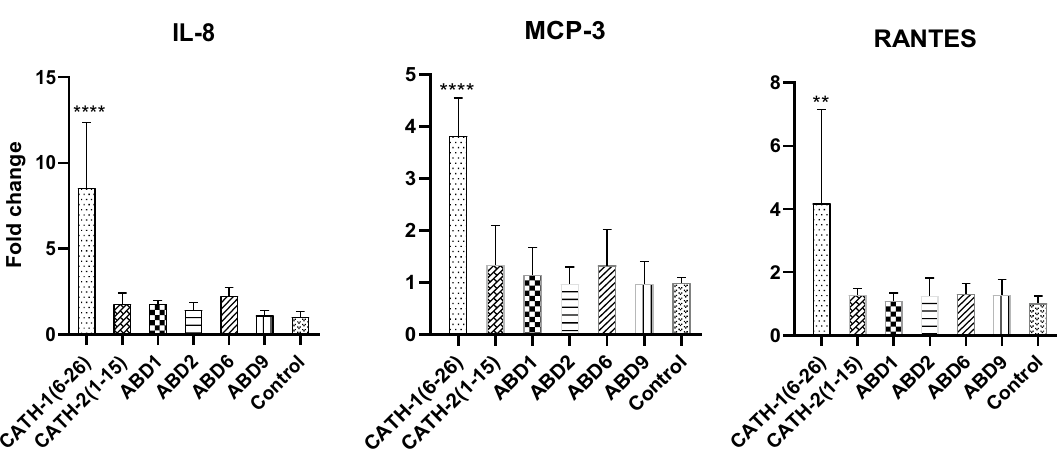
Figure 4. Chemokine induction in HD11 cells post 4 h stimulation of 20 µg/ml synthetic peptides. Data from two separate experiments with three replicates each, means ± SD. Samples from treated groups were compared with the no peptide control using one-way ANOVA with the Dunnett post hoc test. **, **** mean significantly different with p < 0.01 and p < 0.0001,